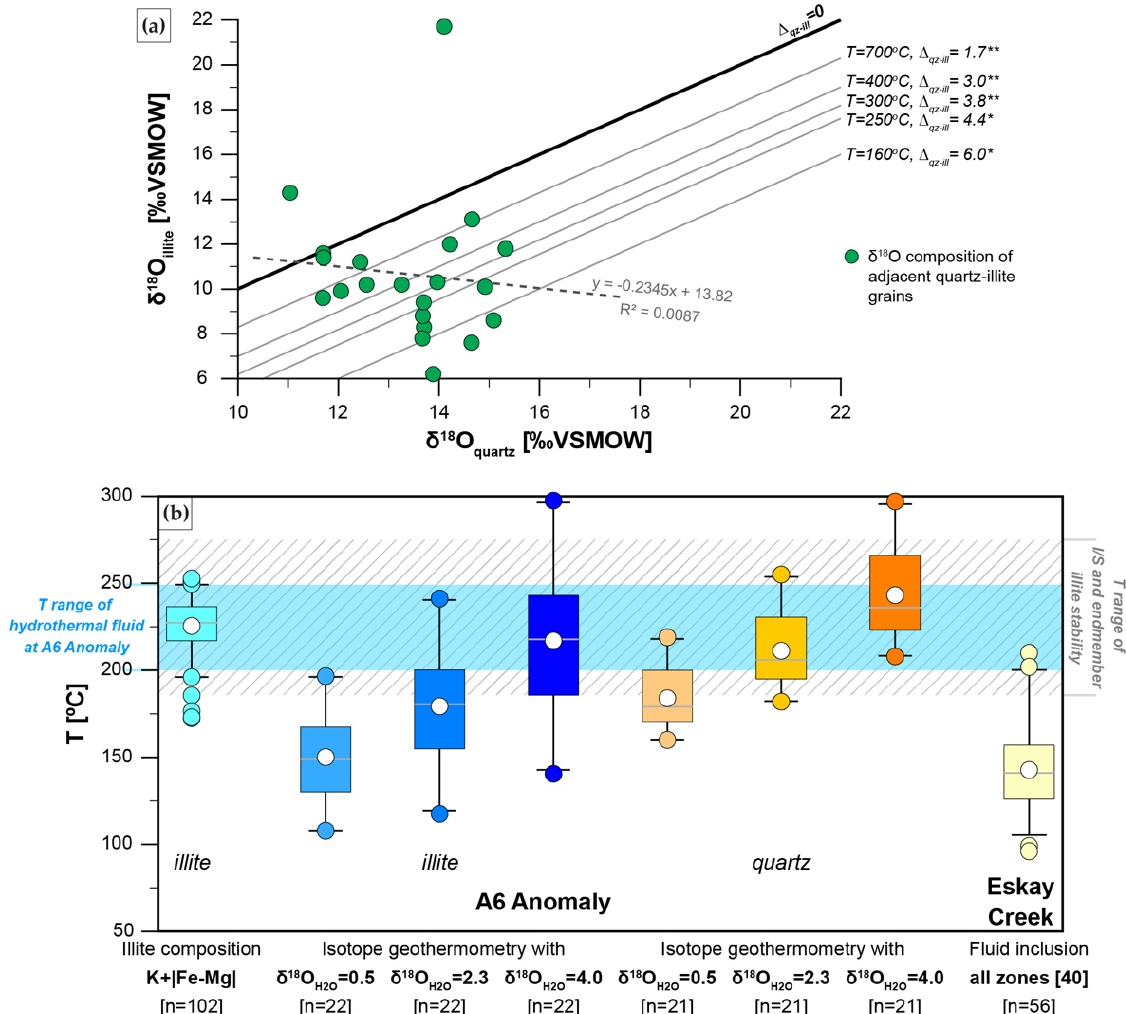
Figure 27. ( a ) δ – δ plot of neighboring quartz and illite grains displaying that quartz and illite are not in isotopic equilibrium, since data points are widely scattered, very poorly correlated (dashed line, R 2 = 0.0087), do not align parallel to isotherms of 160 to 700 °C, or even show reverse fractionation (above thick black line with Δ qz-ill = 0) that is not observed in nature. Isotherms were calculated using: * Δ qz-ill = δ 18 O qz −δ 18 O ill ≈ 1000lna qz-ill = 0.95 × 10 6 /T 2 + 0.9 for T = 160–270 °C [133] and ** Δ qz-ill = δ 18 O qz −δ 18 O ill ≈ 1000lna qz-ill = 0.735 × 10 6 /T 2 + 0.912 × 10 3 /T for T = 200–900 °C [110], ( b ) Percentile box-whisker plot of calculated temperatures of the hydrothermal fluid using illite composition [58], isotope geothermometry for illite-H 2 O and quartz-H 2 O pairs after Sheppard and Gilg [109] and Sharp et al. [108], respectively, with assumed δ 18 O H2O = 0.5, 2.3 and 4‰, and homogenization temperatures of fluid inclusions in quartz and sphalerite from Eskay Creek [37], light blue horizontal bar indicates temperature range of hydrothermal fluid responsible for alteration at the A6 Anomaly and shaded area is stability of I/S and endmember illite without the presence of muscovite, legend as in Figure 17. See text for details and calculations are summarized in Supplementary Materials Table S7.